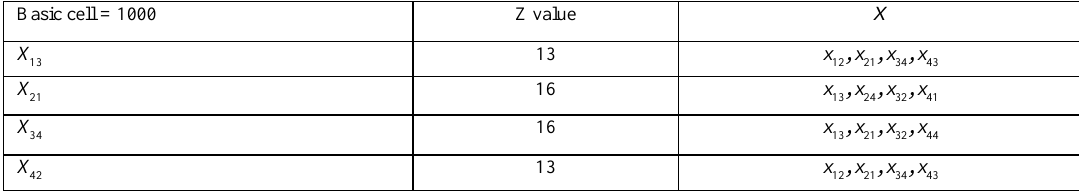
Table 4. Finding the second best the optimal solution using Murty’s approach Basic cell =